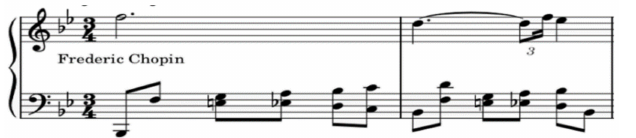
Figure 12. Music notation representing a fragment of F. Chopin’s Prelude Op. 28, No.